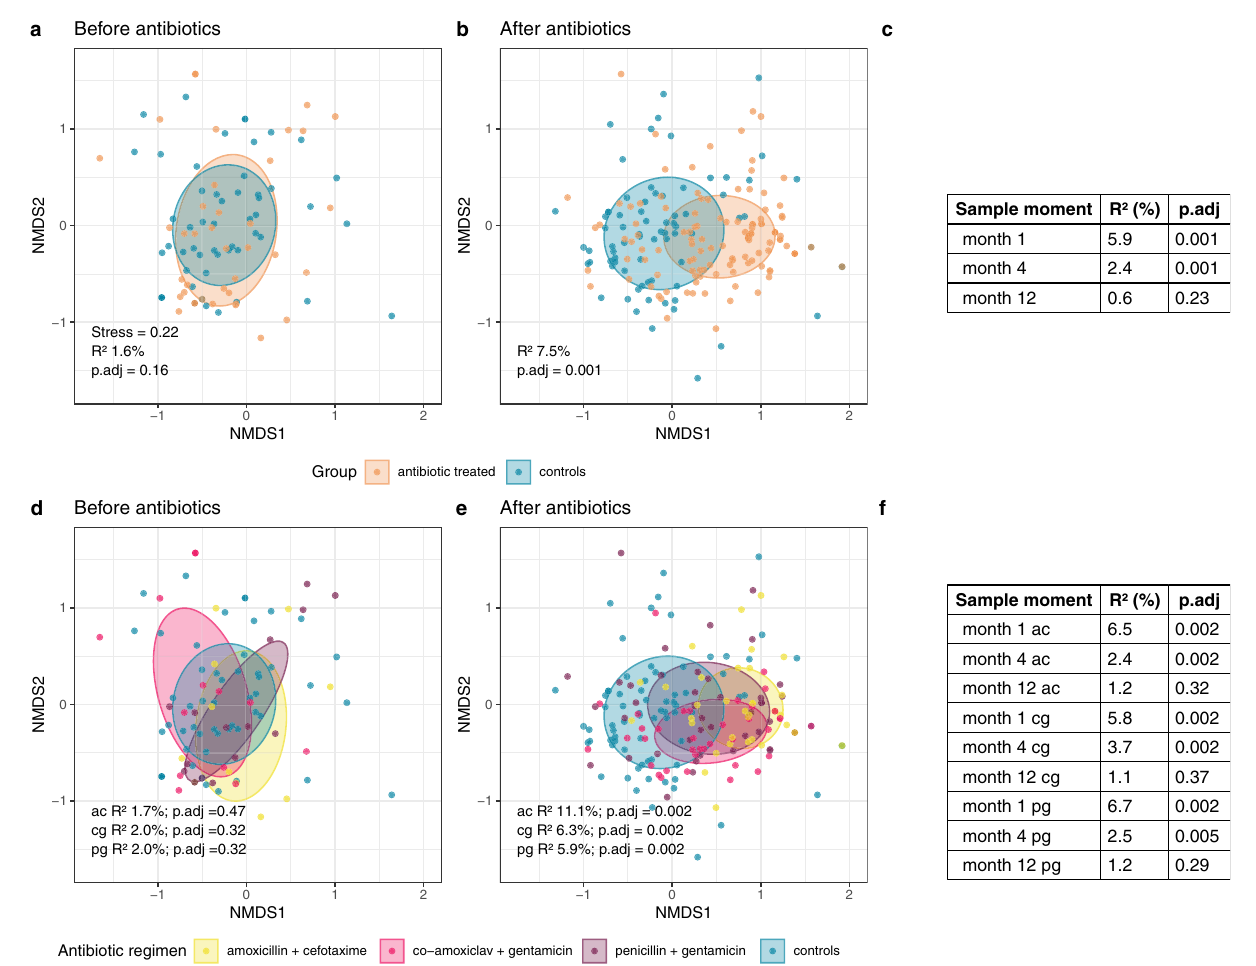
Fig. 4 NMDS plots of AMR gene pro fi le strati fi ed per regimen and time point. Non-metric multidimensional scaling (nMDS) plots, based on Jaccard index of binary (presence/absence) data, visualizing the antimicrobial resistance (AMR) gene pro fi les strati fi ed for antibiotic-treated infants and controls ( a , b ) and per regimen compared with controls ( d , e ), for the time points before and immediately after cessation of antibiotic treatment. Each data point represents the composition of AMR genes of one sample. The ellipses represent the standard deviation of data points belonging to each group, with the center points of the ellipses calculated using the mean of the coordinates per group. The stress of the ordination, effect sizes ( R 2 ) calculated by permutational multivariate analysis of variance (PERMANOVA)-tests and corresponding adjusted p -values ( p .adj, calculated using the Benjamini – Hochberg method) are shown in the plots. In panels c and f the results of the PERMANOVA-tests for the later time points are summarized. Ac = amoxicillin + cefotaxime (yellow), cg = co- amoxiclav + gentamicin (pink), pg = penicillin + gentamicin (purple). Data points of controls are colored teal and those of antibiotic-treated infants (not- strati fi ed per regimen) orange. Source data are provided as a Source Data fi